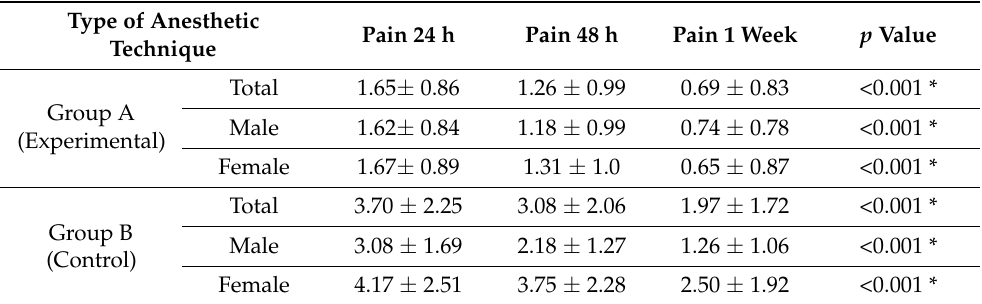
Table 3. Comparison of the mean pain at 24 h, 48 h, and a week in the experimental group (A) and the control group